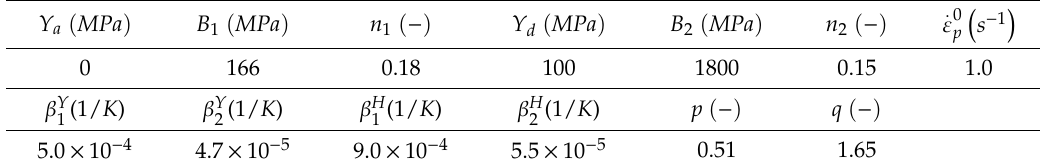
(Figure 1). The athermal- and thermal-related material parameters for Q235B steel used in the VA model are summarized in Table 1. Table 1. Material parameters used in the Voyiadjis–Abed (VA) model for Q235B.